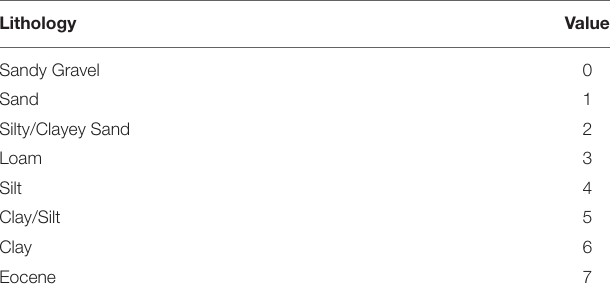
TABLE 2 | Values assigned to lithologies for the 3-D Quaternary